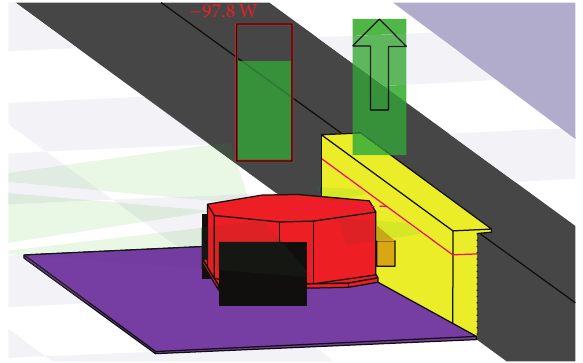
Figure 4: A closed view of mobile robots during charging at power